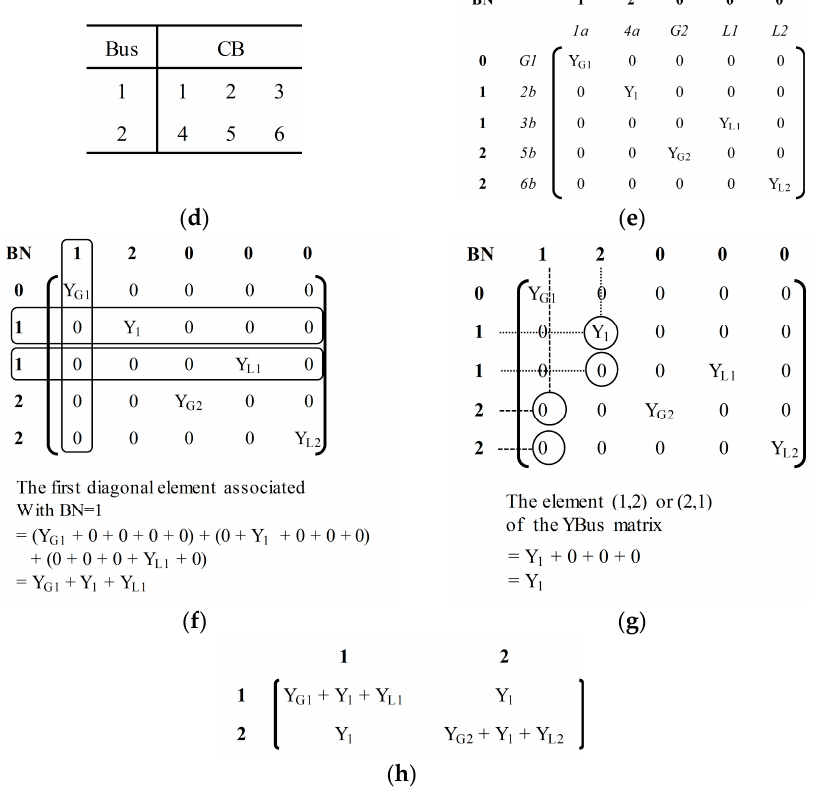
Figure 3. Conversion of TM into the Ybus Matrix. ( a ) TM; ( b ) Conversion Matrix (CM); ( c ) Base Matrix (BM); ( d ) Conversion Table; ( e ) Modified Base Matrix; ( f ) Computation the first diagonal element of the YBus Matrix; ( g ) Computation of the remaining elements of the YBus Matrix; ( h ) YBus Matrix.